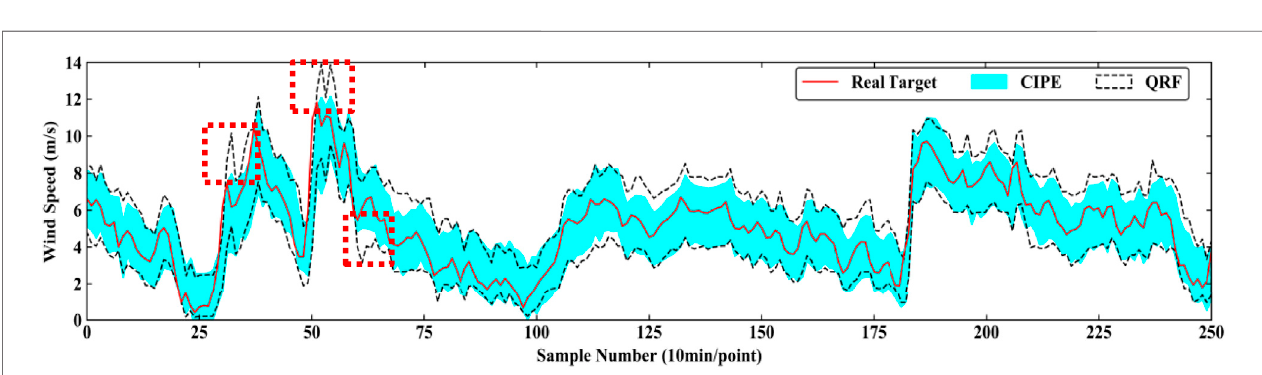
FIGURE 6 | Prediction result of CIPE and QRF under PINC = 95% in 1-step ahead prediction.